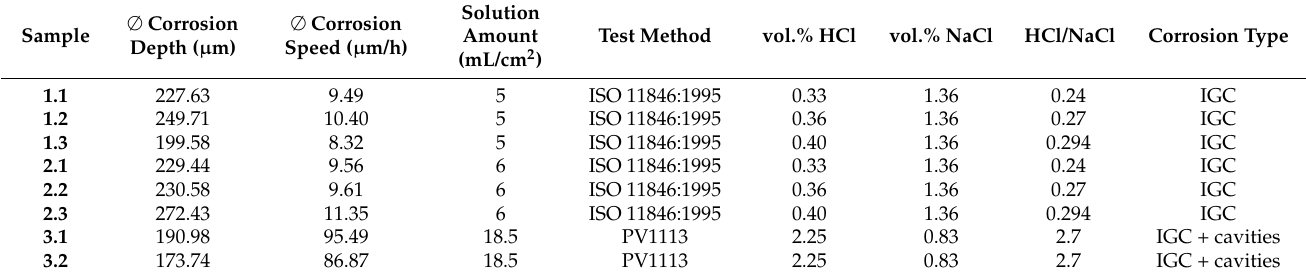
Table 4. Average corrosion depth and speed of the tested samples. Fractions of HCl and NaCl are also shown.